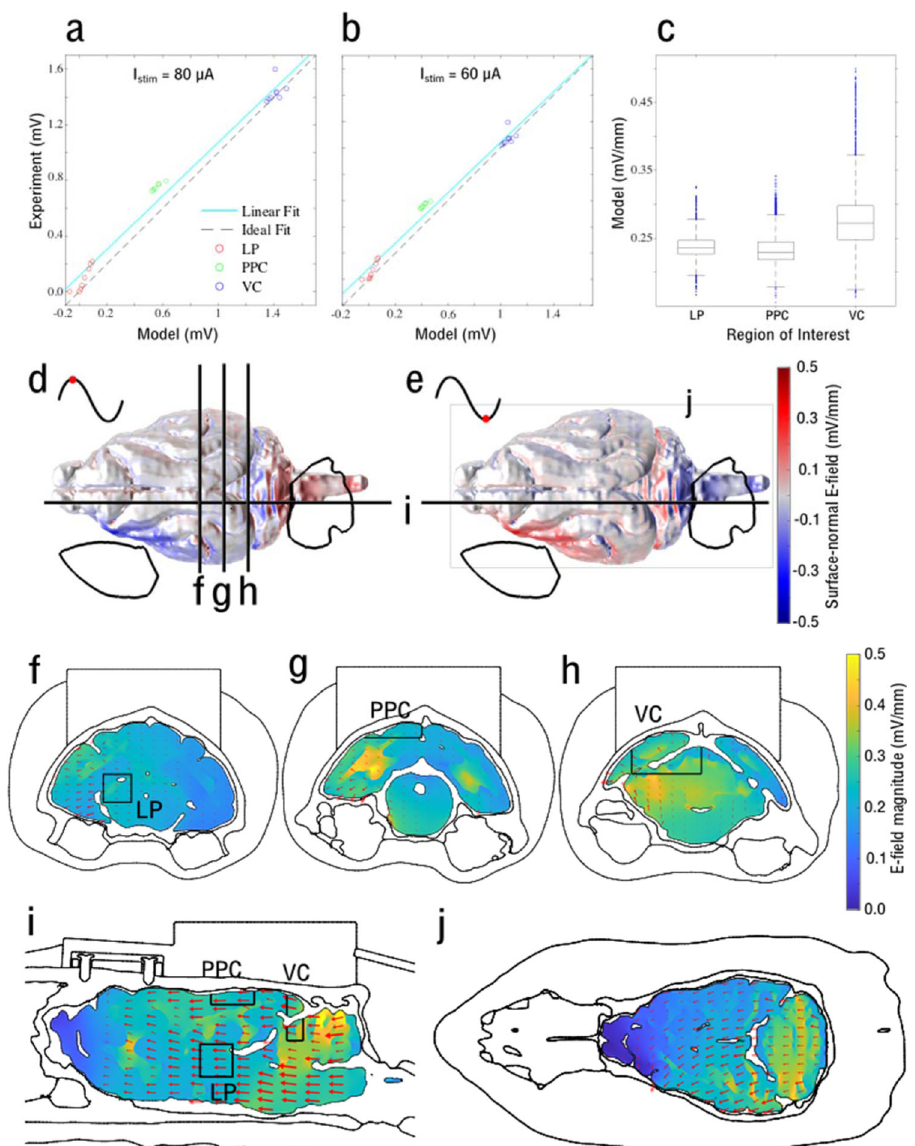
Fig. 4 Measurement and modeling of the tACS electric fi eld in the ferret brain. a , b Comparison between recorded and simulated electric potentials using stimulation current intensity of 80 µ A and 60 µ A in three recording sites: LP, PPC, and VC with 8, 6, and 8 grid electrodes, respectively. The y axis represents the experimental values averaged over n = 6 measurements (2 blocks and 3 electrode reference schemes), while the x axis shows the corresponding potential value from the model. The solid cyan line represents the linear regression of the data, which ideally should match the dashed black unity line. c Distribution of the electric fi eld magnitude in the three ROIs, predicted by the model. The central mark in each box indicates the median, and the bottom and top edges indicate the 25th and 75th percentiles, respectively. The whiskers extend to the most extreme data points not considered outliers (99.3% of the data), and the outliers are plotted as blue dots. The number of samples in each ROI correspond to the number of fi nite elements: n = 2327, 8782, and 7944 for LP, PPC, and VC, respectively. These data demonstrate a relatively weak electric fi eld of ~0.25 mV/mm in the ROIs. Source data are provided as a Source Data fi le. d , e Spatial distribution of the magnitude of the electric fi eld surface-normal component (min: − 0.497mV/mm, max: 0.507mV/mm) on the brain surface at, respectively, 90° and 270° phase of the tACS wave (red dots on a cycle of sinewave). The electric fi eld magnitude is greatest in areas proximal to stimulation electrodes (open black circles in left frontal and midline occipital regions). The direction of the surface-normal electric fi eld fl ips according to the tACS phase. f – j The electric fi eld distribution along three coronal sections (including ROIs), one sagittal section (horizontal lines in d and e ), and a transversal section is displayed in f – j . The model prediction shows that the electric fi eld magnitude is <0.5 mV/mm in all sections. The maximum electric fi eld (bright yellow) occurs outside the ROIs. Arrows representing the direction of the electric fi eld components are scaled in length by the electric fi eld strength in the plane of the sections in f – j and demonstrate dominant posterior – anterior electric fi eld synchronization map between single units and tACS that induced pattern indicative of their weak entrainment by tACS. The VC an electric fi eld of < 0.5 mV/mm across the ferret brain. The units demonstrated a partial Arnold tongue, and no regular synchronization region follows a triangular Arnold tongue shape, pattern of synchrony was observed for LP neurons. Among with phase-locking values that are just slightly higher than their narrow- and broad-spiking neurons, the former ones showed neighbor regions. The PPC units exhibited an Arnold tongue more de fi ned Arnold tongue regions.